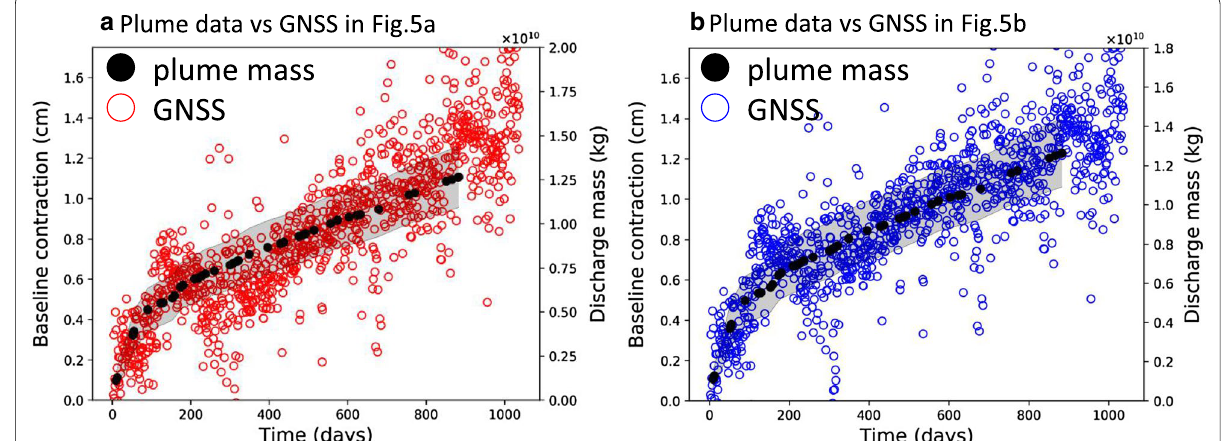
Fig. 7 Schematic illustration of mass balance between the two deflation sources and the discharged plume. Q s , Q d and Q out correspond to extruded fluid from the shallow source, the deep sources and the discharged plume, respectively. Δ V s is deflated volume of the shallow source. Δ L d indicates baseline contraction due to the deep deflation. Deformation at the surface caused by deflations of deep and shallow sources brings displacements of GNSS stations and change in LOS distance toward the satellite